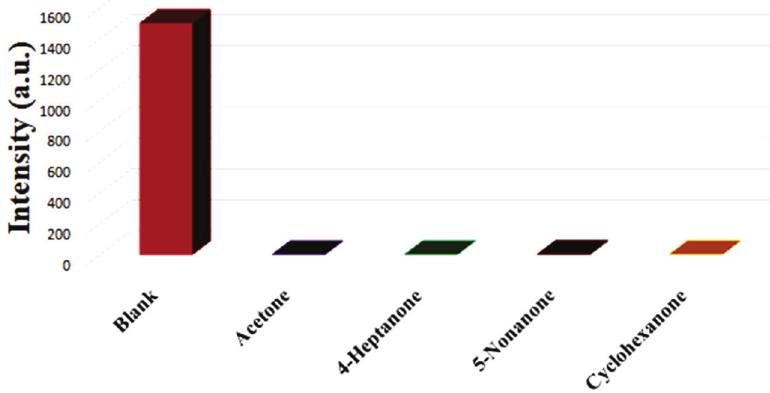
Figure 7. Fluorescence intensity of complex {[Zn(bipy) 2 (H 2 O)](ClO 4 ) 2 }( 1 )in various ketones upon excitation at 295 nm.